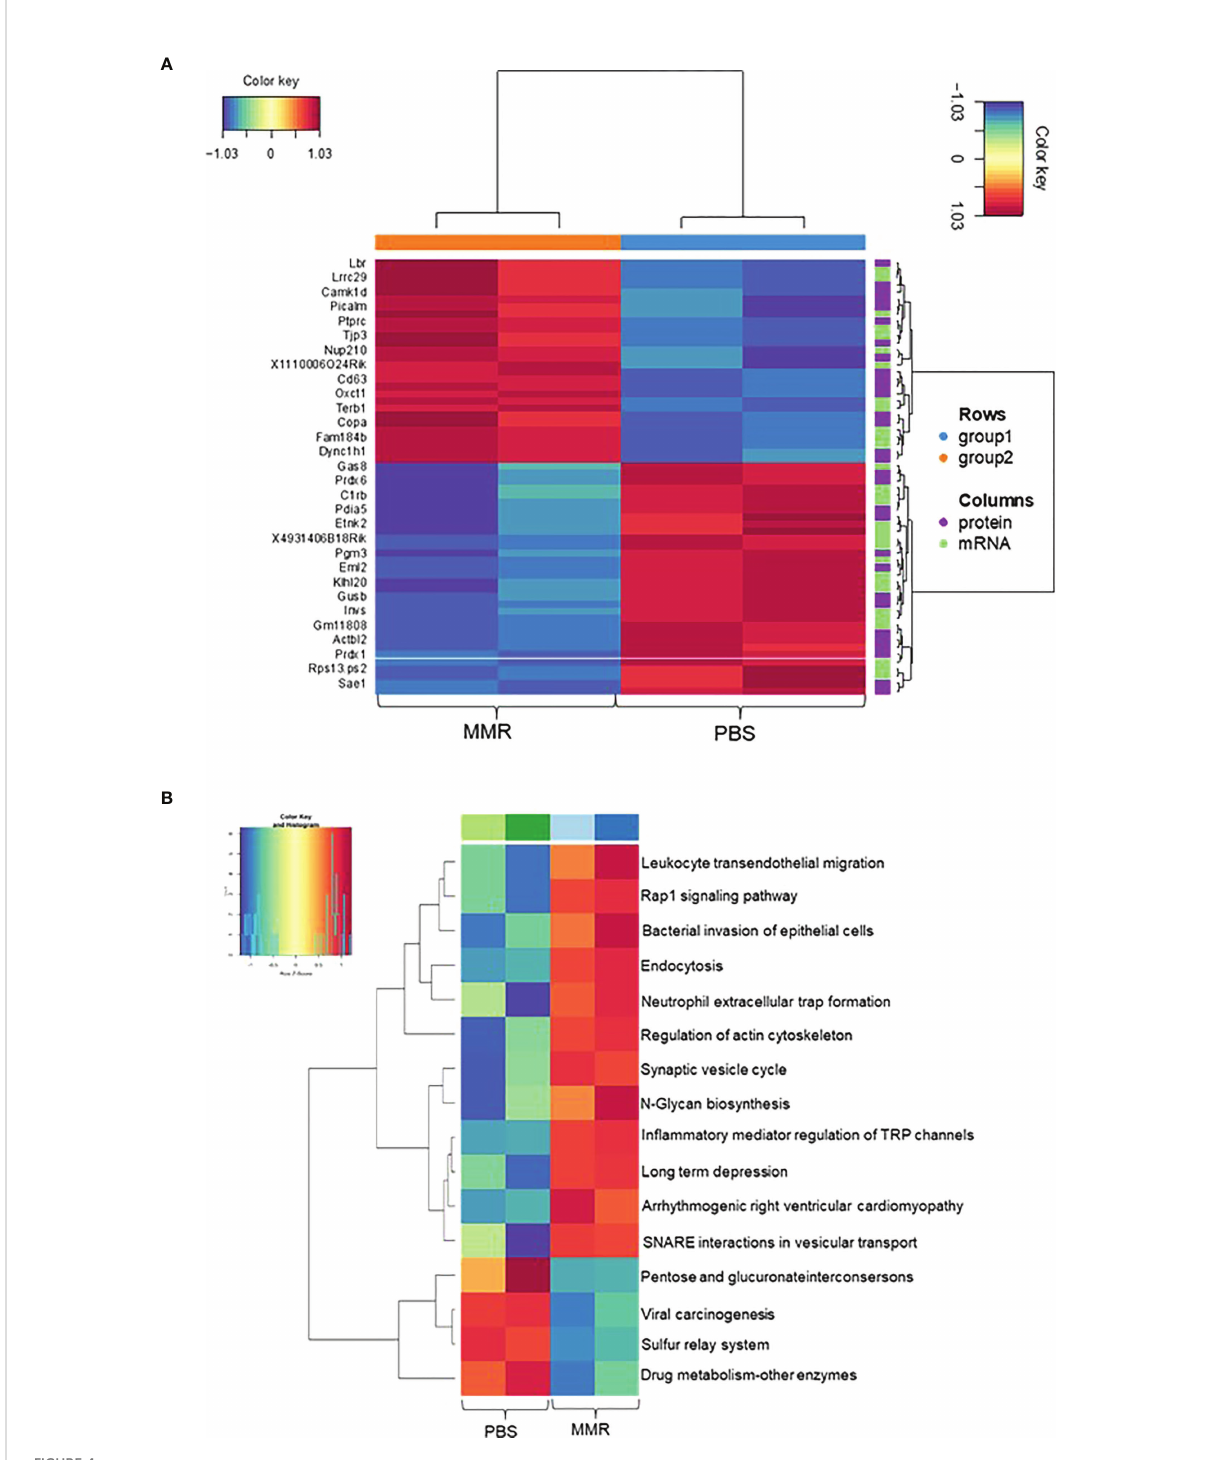
FIGURE 4 Integration Analysis between transcriptome and proteome data of Hepa 1-6 tumors treated with MMR. A MixOmics supervised analysis was carried out between DEGs and differentially expressed proteins (DEPs) based on Log2 fold change values. Log2 fold change of DEG × Log2 fold change of DEP >0 with a P-value of DEG and DEP <0.05 were considered associated DEGs/DEPs. (A) DEG/DEP expression heatmap of the 30 most up-regulated and down-regulated features in MMR vs. PBS groups. (B) Heatmap displaying enriched biological pathways fi ltered based on consistency between all MMR or PBS